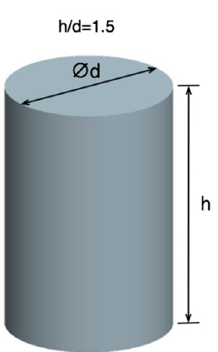
Figure 4. Schematic illustration of cylindrical specimens.